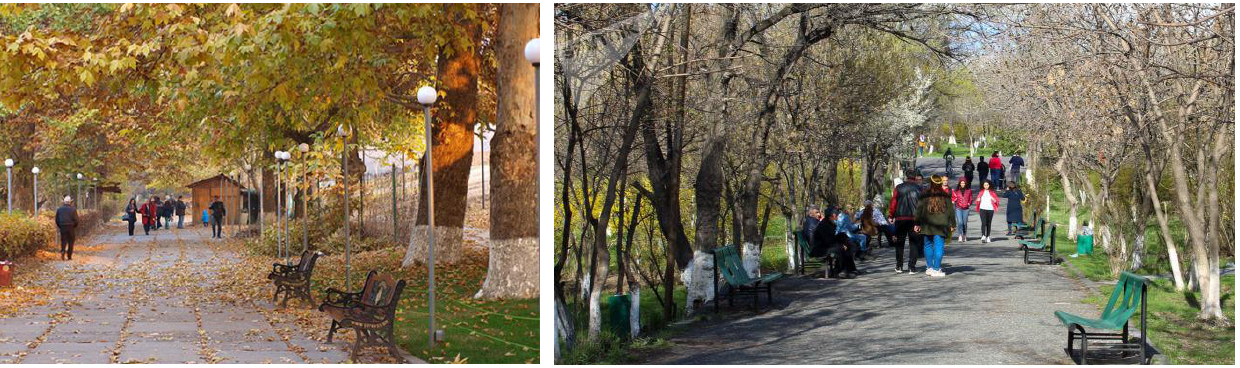
Figure 3. “Oghakadzev” park Figure 4. Nansen